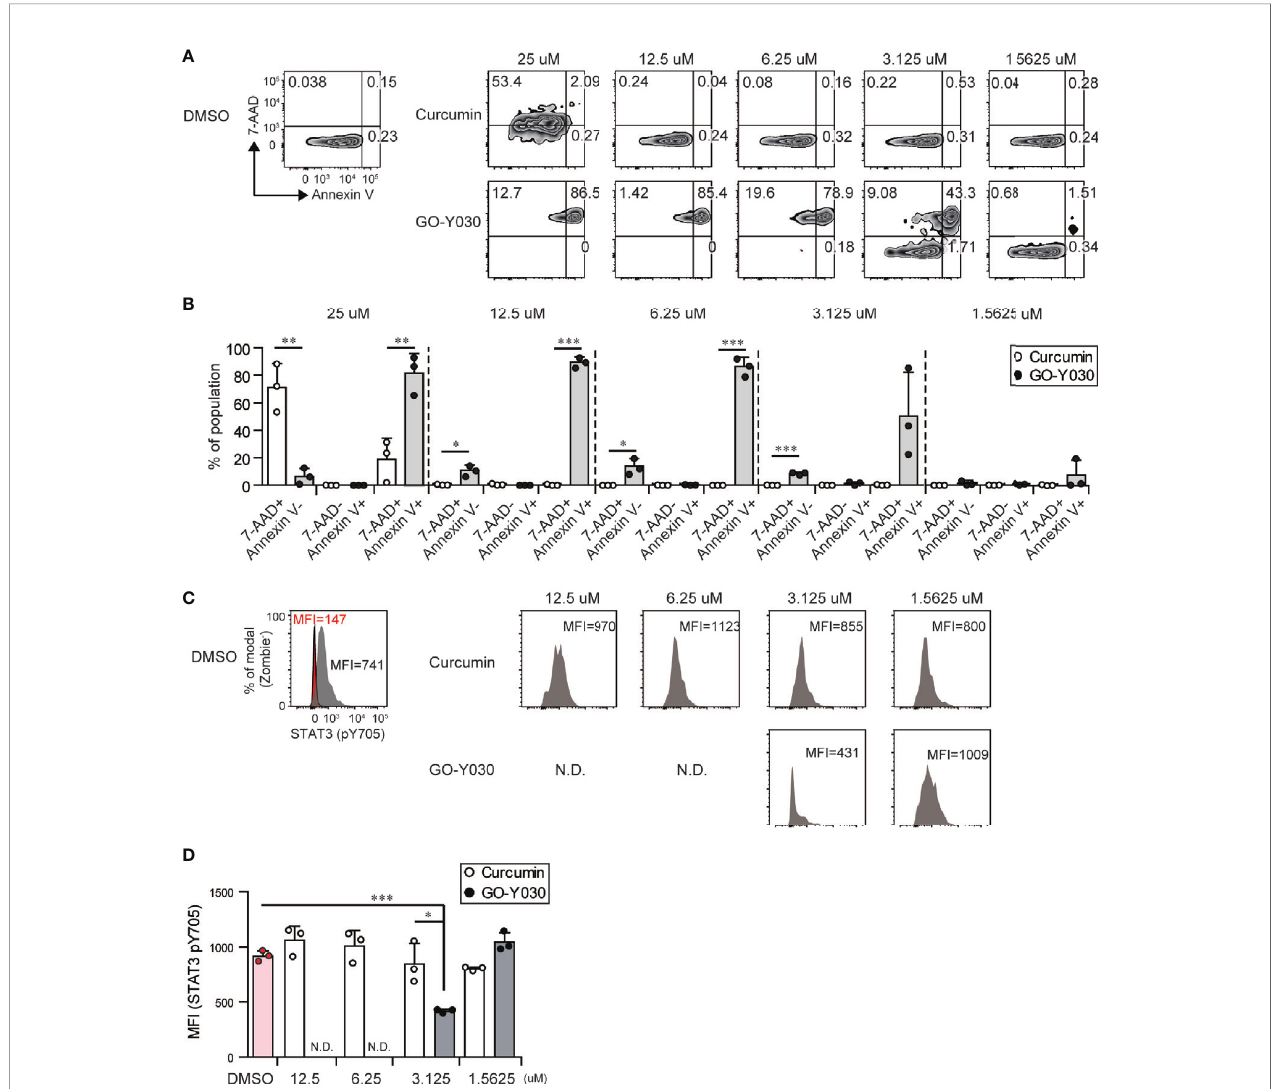
FIGURE 5 | GO-Y030 induces tumor cell death and prevents STAT3 activation. (A – D) The B10-F16 tumor cell line was treated with each concentration of curcumin or GO-Y030 for 72 h. The data are representative at three independent experiments. (A) Representative 7-AAD and Annexin V staining by FACS. (B) Cell death percentages of each population. White, curcumin treatment; black, GO-Y030-treatment. (C, D) Representative Stat3 (pY705) mean fl uorescent intensity by FACS analysis. Gray, isotype control; red, STAT3 (pY705). N.D., not detected live cells (Zombie - population). A one-way ANOVA with post-hoc Tukey ’ s multiple comparison test was used. *P< 0.05, **P < 0.01, ***P <